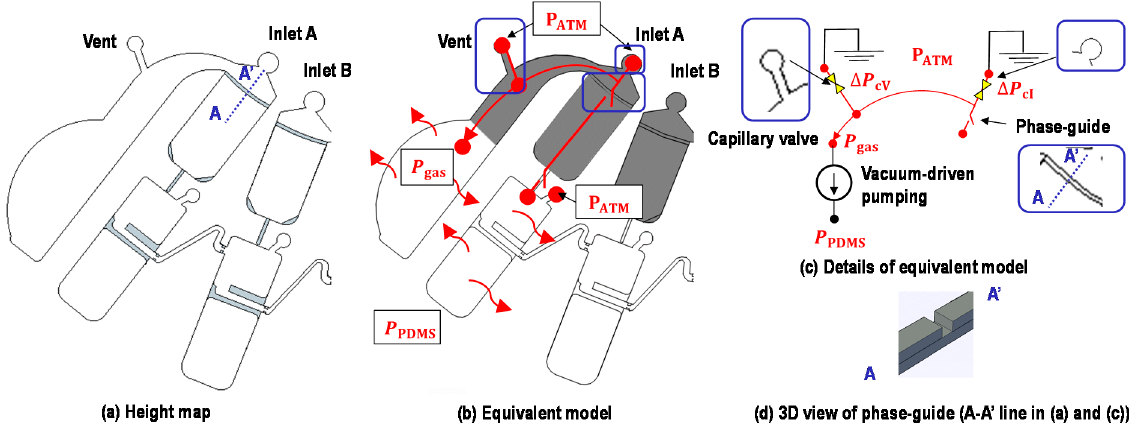
Figure 5. A height map and equivalent model for the vacuum-driven metering process. ( a ) Colored parts were designed to have 210 µ m, while non-colored parts were designed to have 420 µ m. Along with lateral geometrical confinements, the height differences assist in determining the fluidic passage (such as liquid sample stop, split, confinement, etc.). ( b ) Equivalent model and ( c ) details of equivalent model. Colored parts represent the liquid filling parts before the metering. The pressure difference across the liquid column is generated due to the gas solubility of degassed PDMS, driving liquids into the dead-end channel/chamber. Geometrical confinement by phase-guide structures would play a role in metering the liquids. P ATM is the atmospheric pressure, P gas is the pressure inside the chamber, P PDMS is the pressure associated with degassed PDMS, and ∆ P cV and ∆ P cI are the capillary pressure of the capillary valves at the vent and the inlet, respectively. ( d ) 3D schematic view of phase-guide for one side of a PDMS layer.